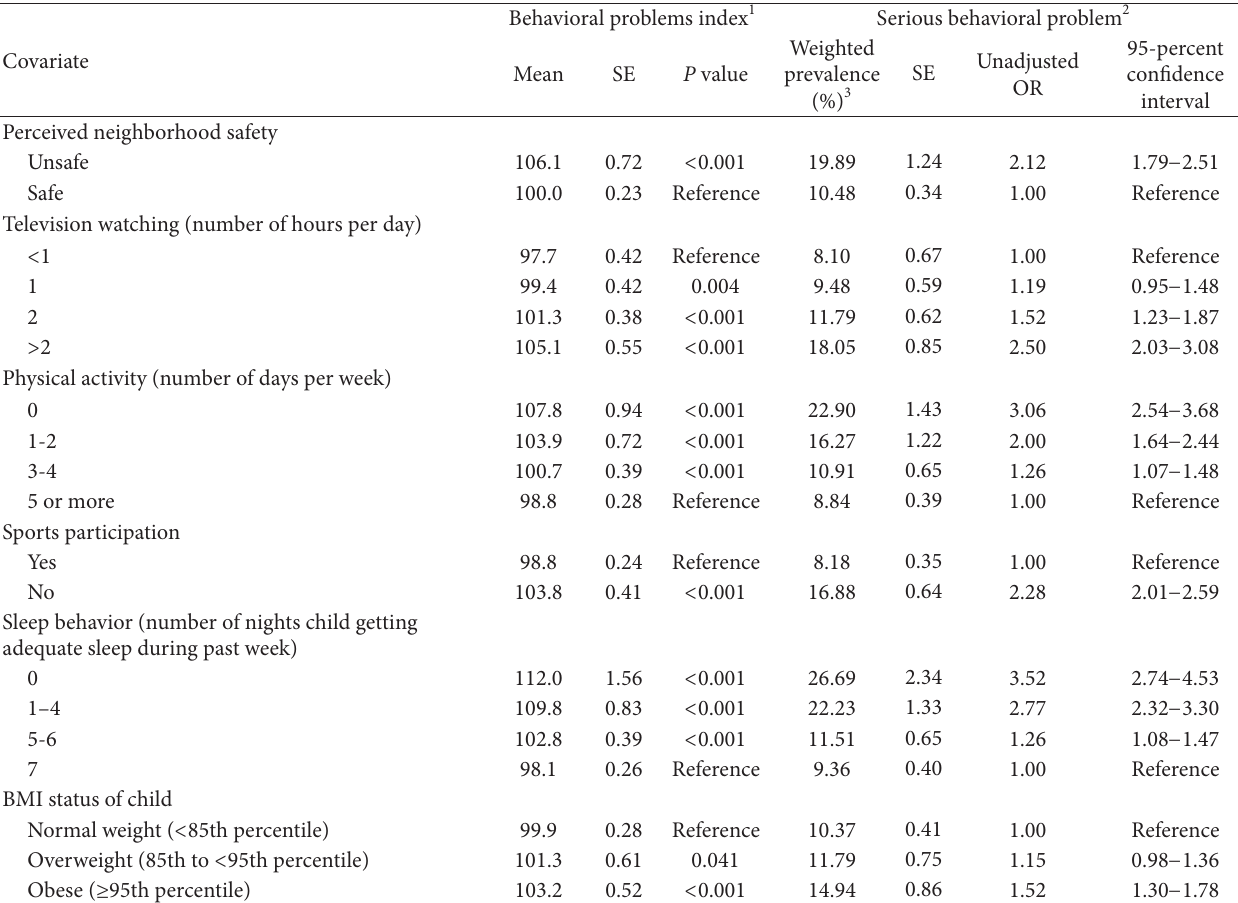
Higher scores on the index indicate higher levels of behavioral problems. 2 is binary outcome variable was de�ned on the basis of whether or not the child had a BPI score test for the overall association between each covariate and the prevalence of serious behavioral problems was statistically signi�cant at